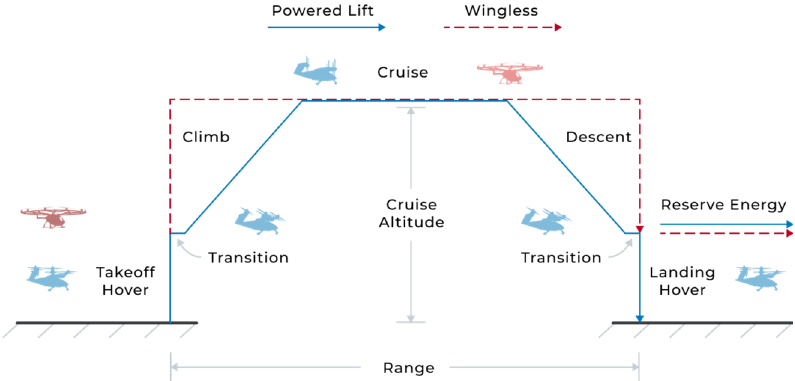
Figure 3. A representative mission profile for the powered lift and wingless eVTOL aircraft